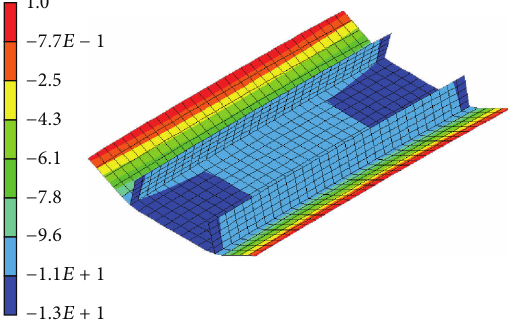
for the panel structure with two longitudinal stiffeners.